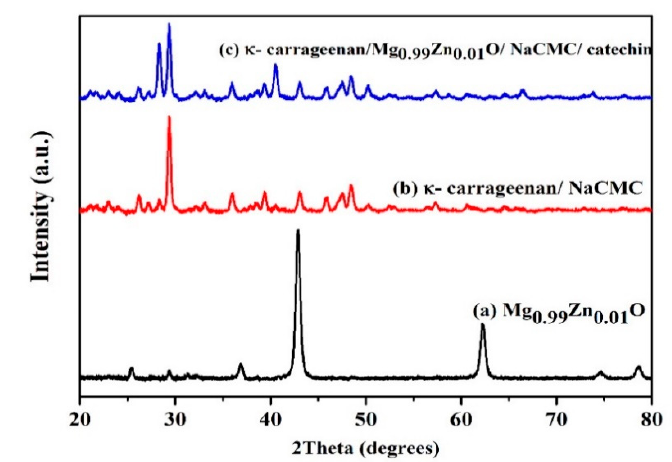
Figure 3. XRD patterns of (a) Mg 0.99 Zn 0.01 O, (b) κ -carrageenan/NaCMC, and (c) κ -carrageenan/ Mg 0.99 Zn 0.01 O / NaCMC/ Catechin .